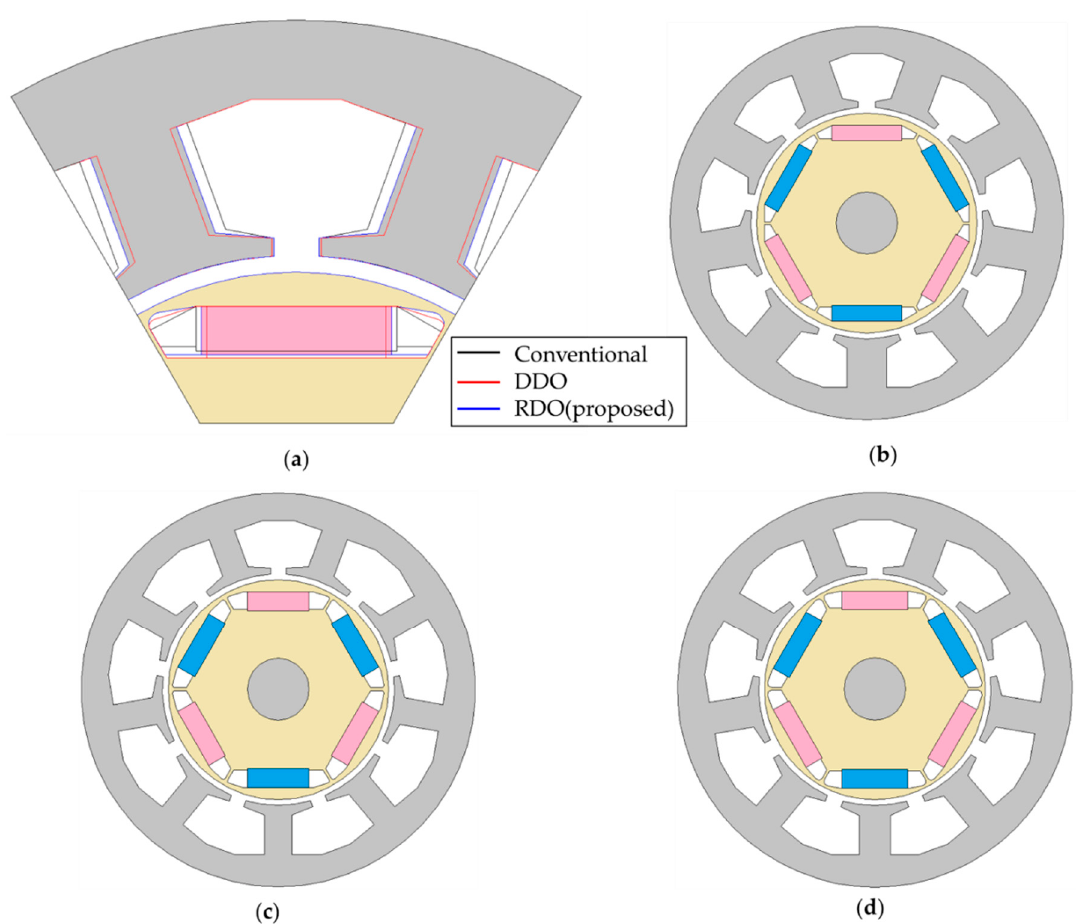
Figure 7. Shape comparison: ( a ) Comparison; ( b ) Conventional; ( c ) Deterministic design optimization (DDO); ( d ) RDO (proposed).